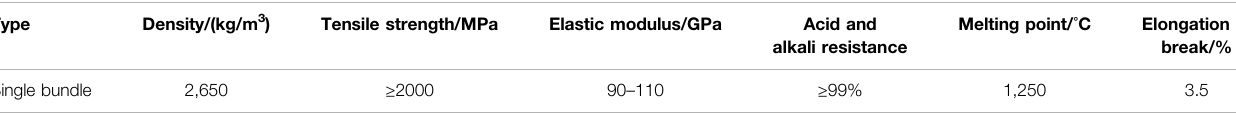
TABLE 2 | Mechanical properties of basalt fi bre.